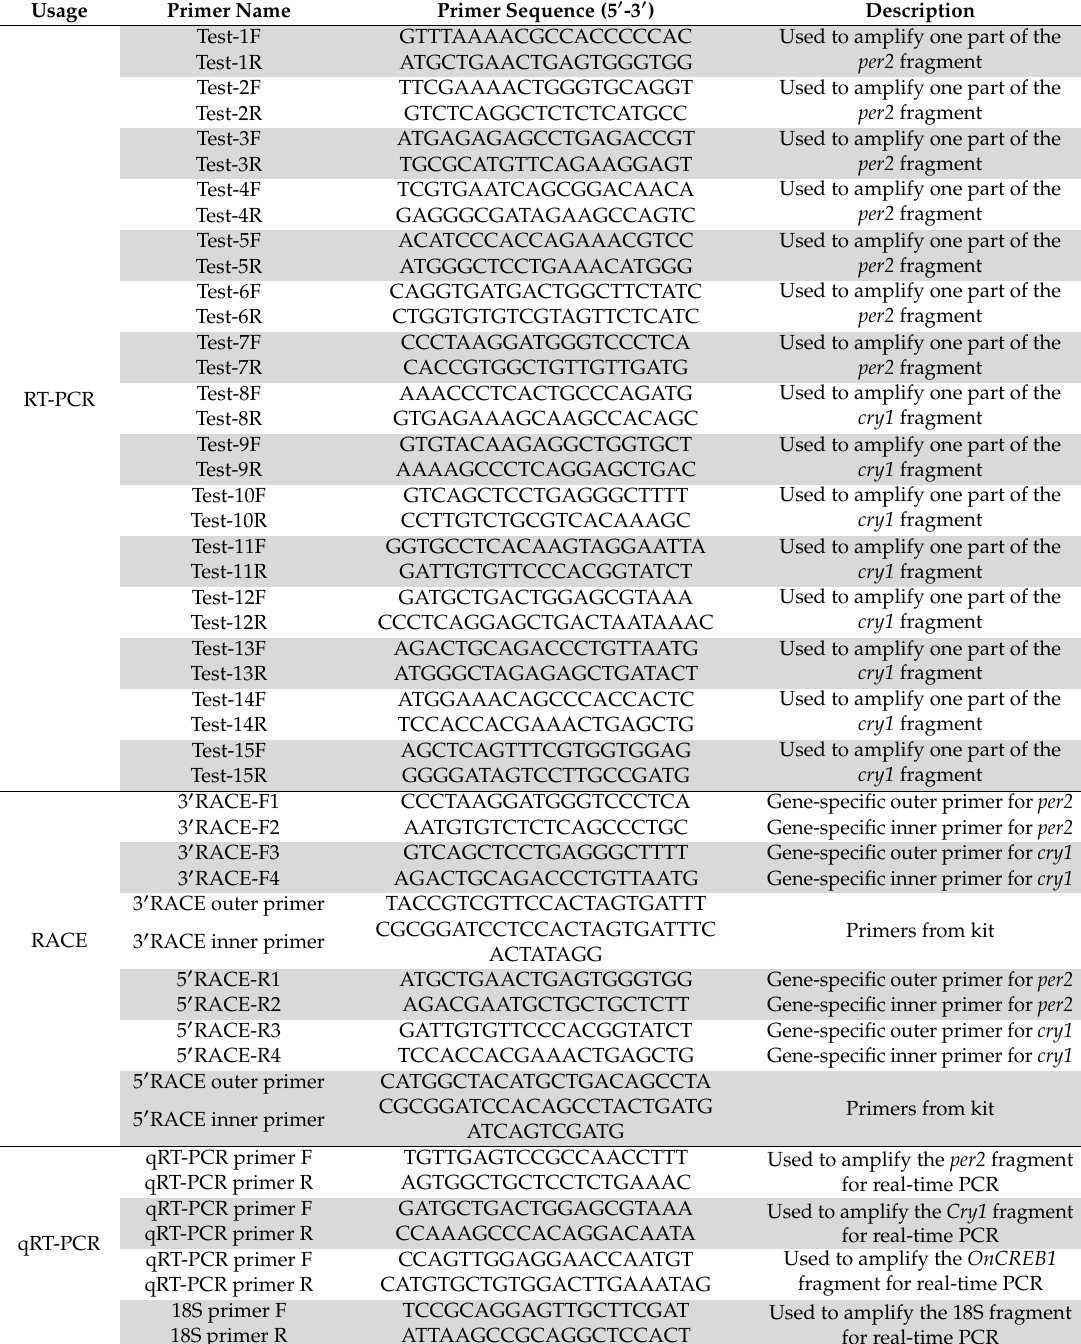
Table 1. Polymerase chain reaction (PCR) primers used in gene cloning and realtime